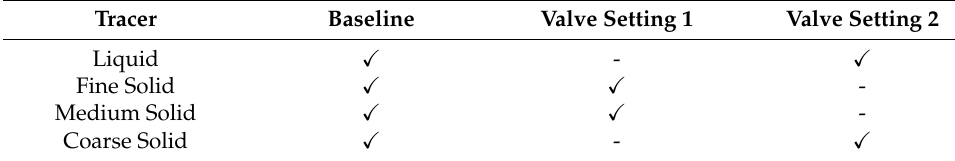
Table 1. Types of tracers employed in the pulp distribution measurements.